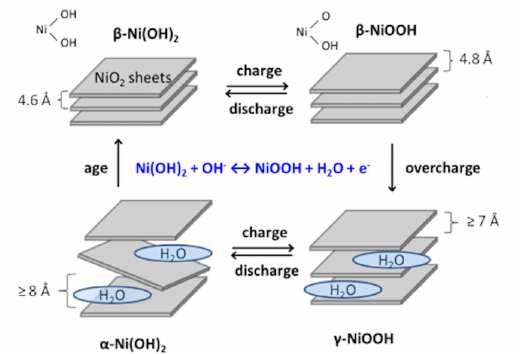
Figure 6. Description of the redox transformation of Ni(OH) 2 /NiOOH. Retrieved from [167].